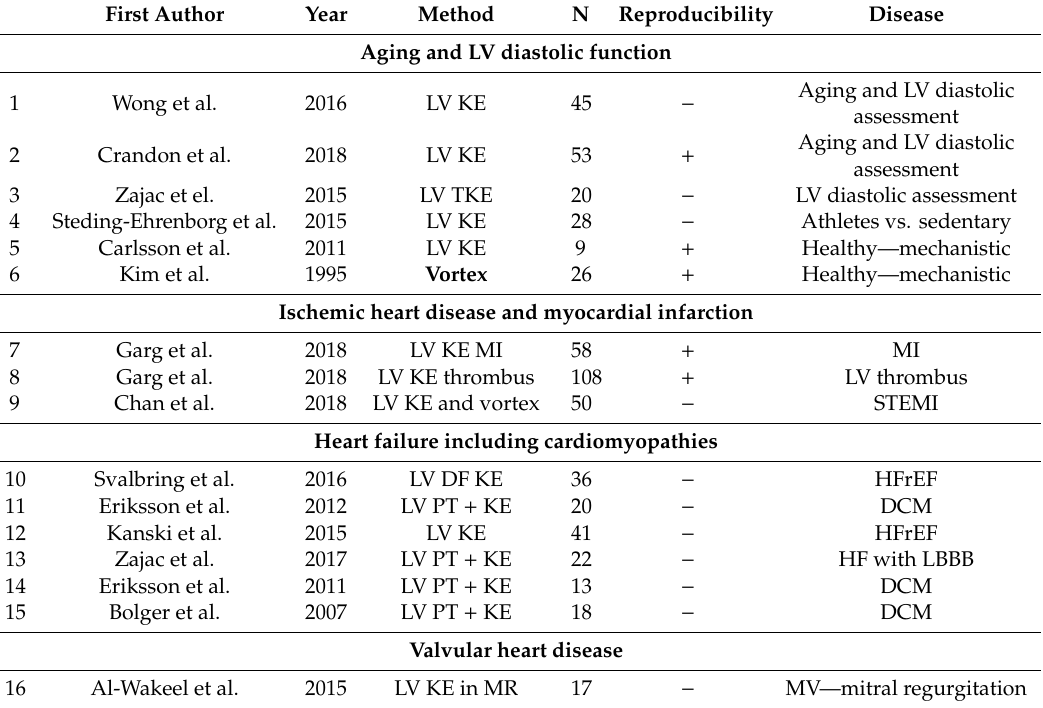
Table 1. Characteristics of studies included in this systematic